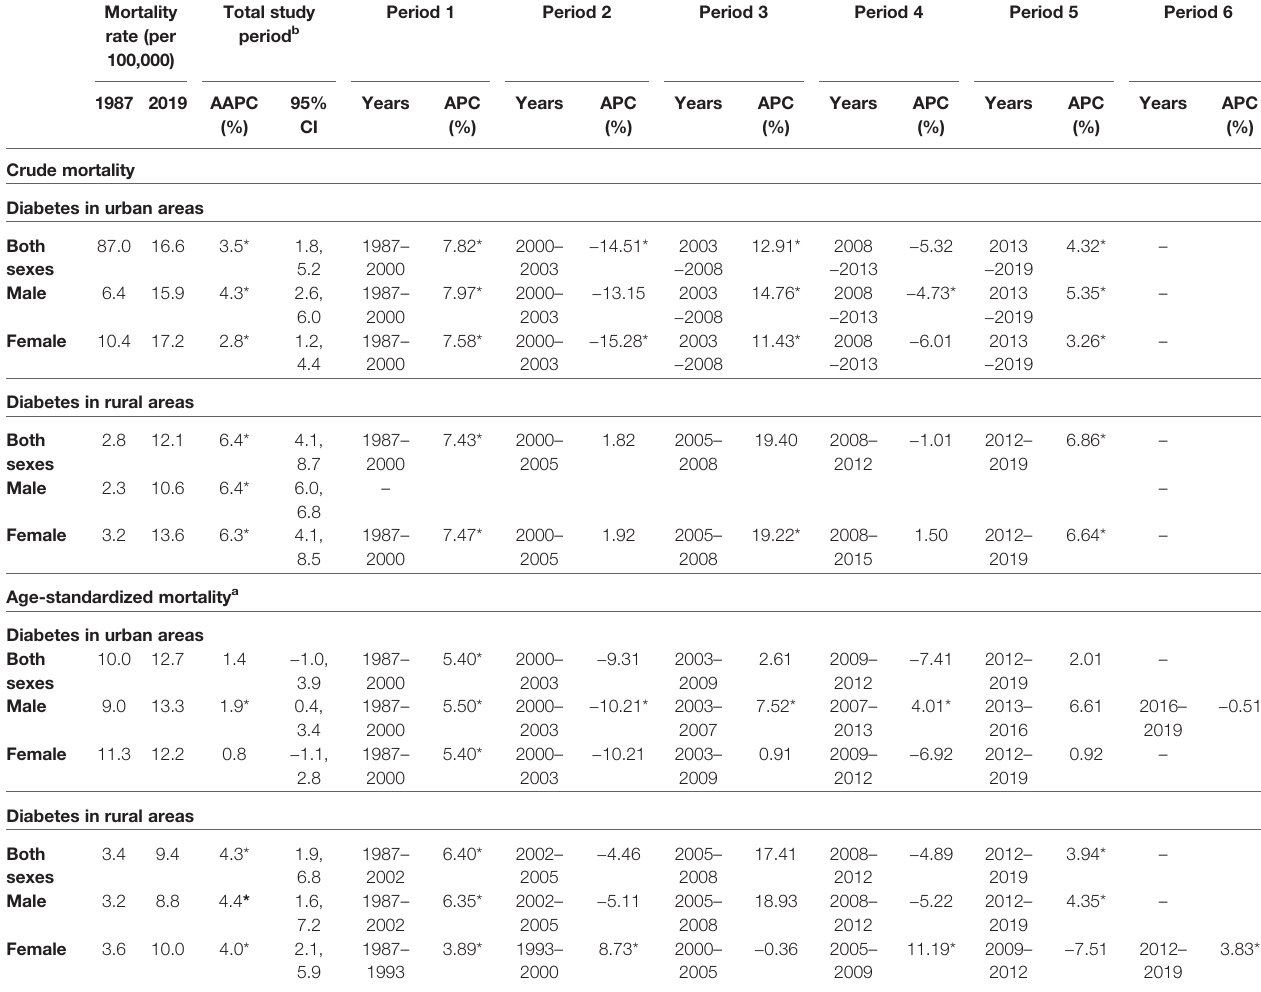
TABLE 1 | Joinpoint analysis of crude and age-standardized mortality rates of diabetes in urban and rural areas. Mortality rate